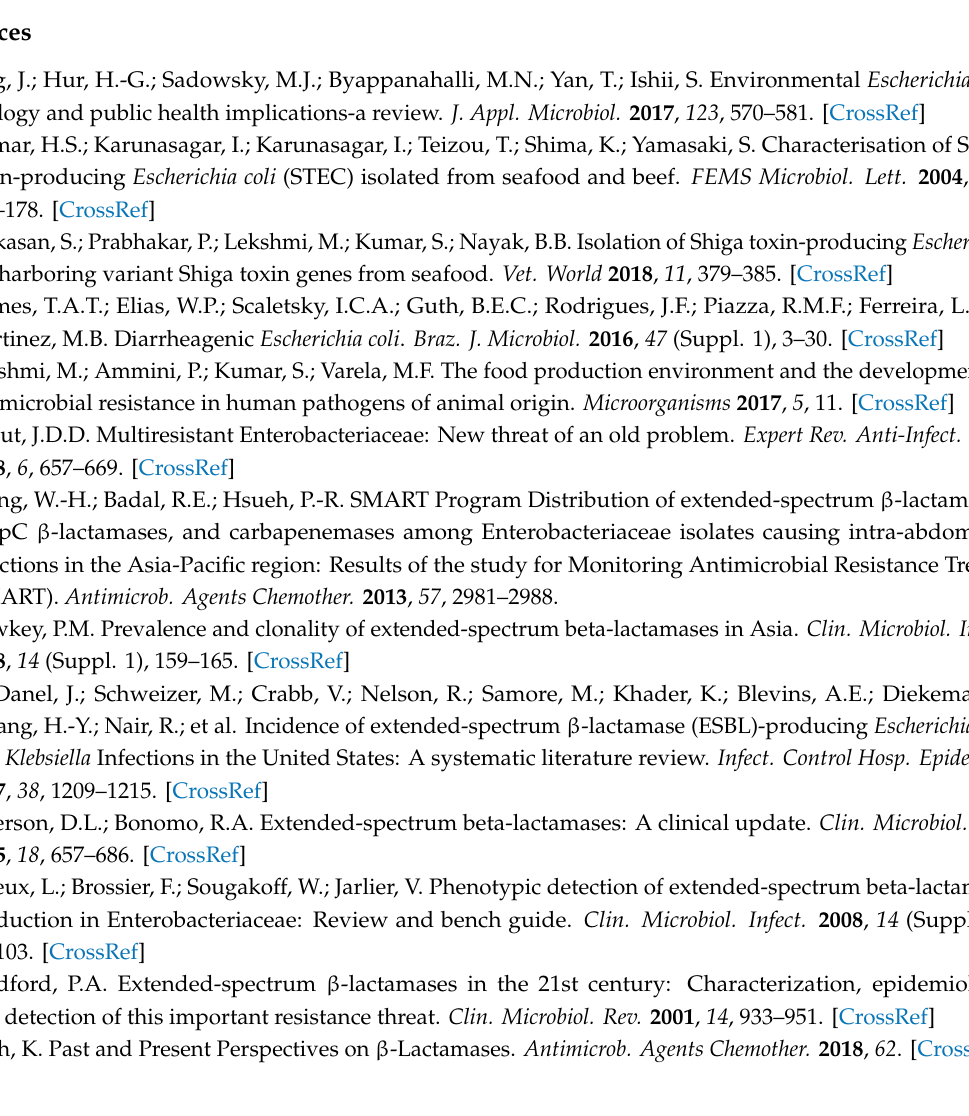
Table S1: Oligonucleotide primers used in this study for the detection of antibiotic resistance